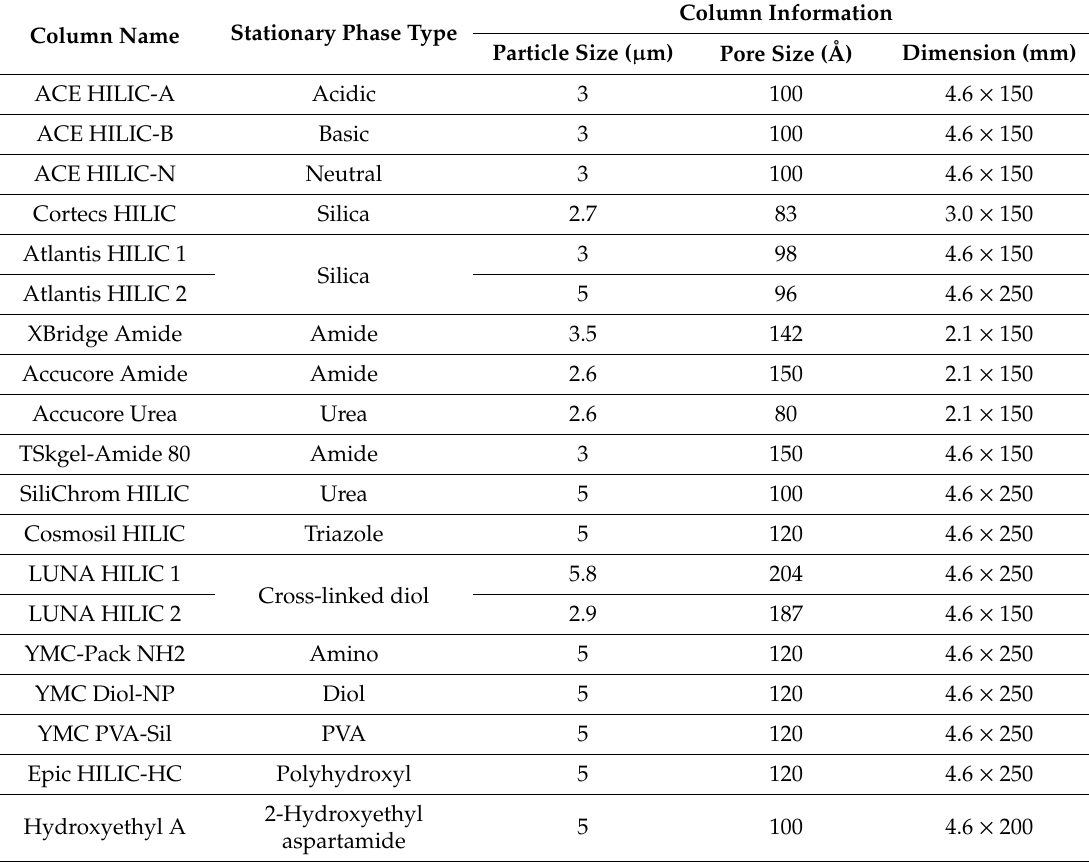
Table 2. Detailed Information of the selected polar stationary